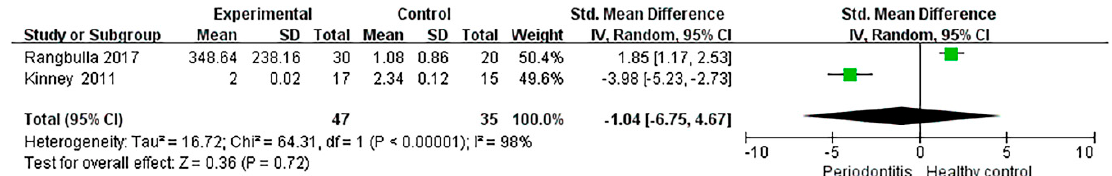
Figure 2. Effects on salivary IL-1 β after non-periodontal surgery therapy. Note: green color, random effect interval in each study; black, total effect.